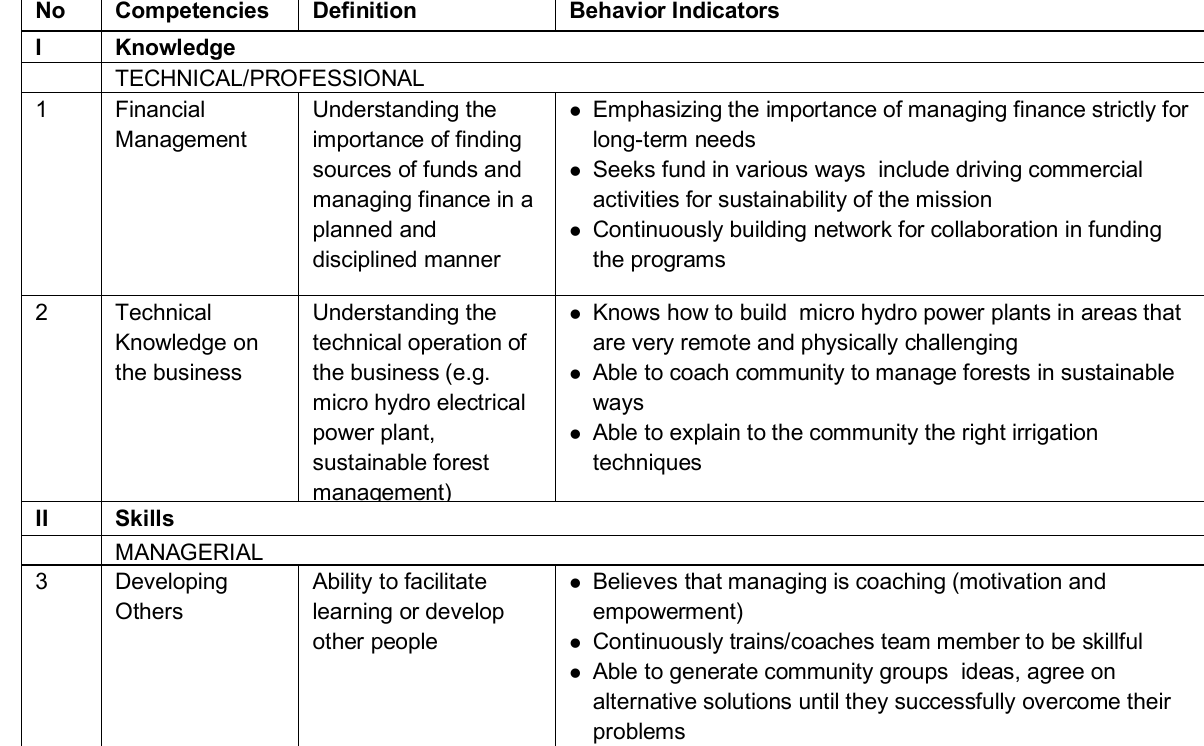
Table 2: Proposed Competency Model of Social